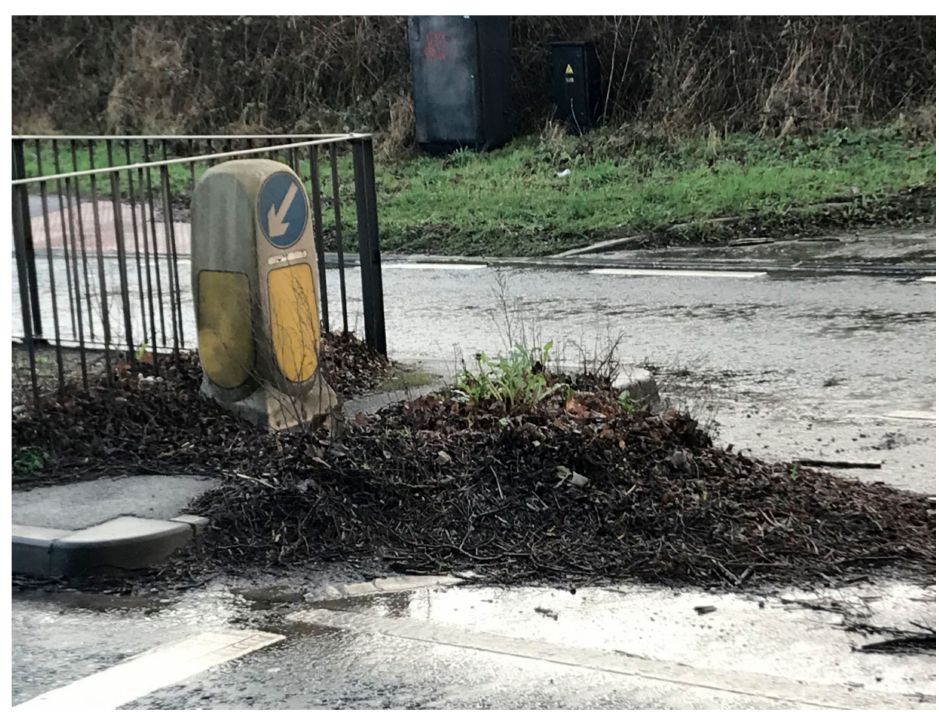
Figure 3. Entrained waste material behind road furniture at an urban setting in the UK. The material comprises a combination of natural leaf litter, sludge, and vehicle components. Copyright by Gillian